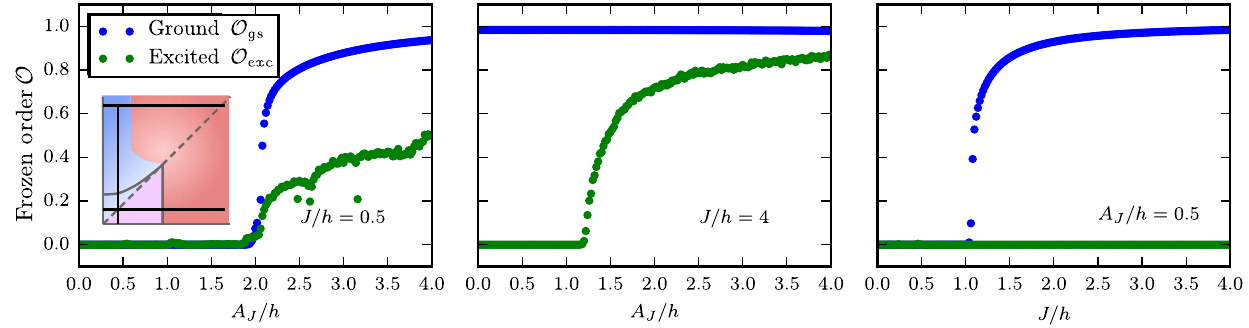
FIG. 3. The Ising glass order parameter O along three representative cuts in the phase diagram (inset). The definitions of O are given by Eqs. (24) and (35), respectively. The spatial averaging window is of size w ¼ 5 , and we sample 50 eigenstates in the excited-state average. In the first panel, both the ground- and infinite-temperature order turn on at the same coupling as the excitations localize across the transition. In the second panel, the ground-state order is unchanged even as the excited-state order turns on because of the localization of the domain walls. In the third panel, the ground-state order turns on, but the excitations are extended so that the excited-state order remains